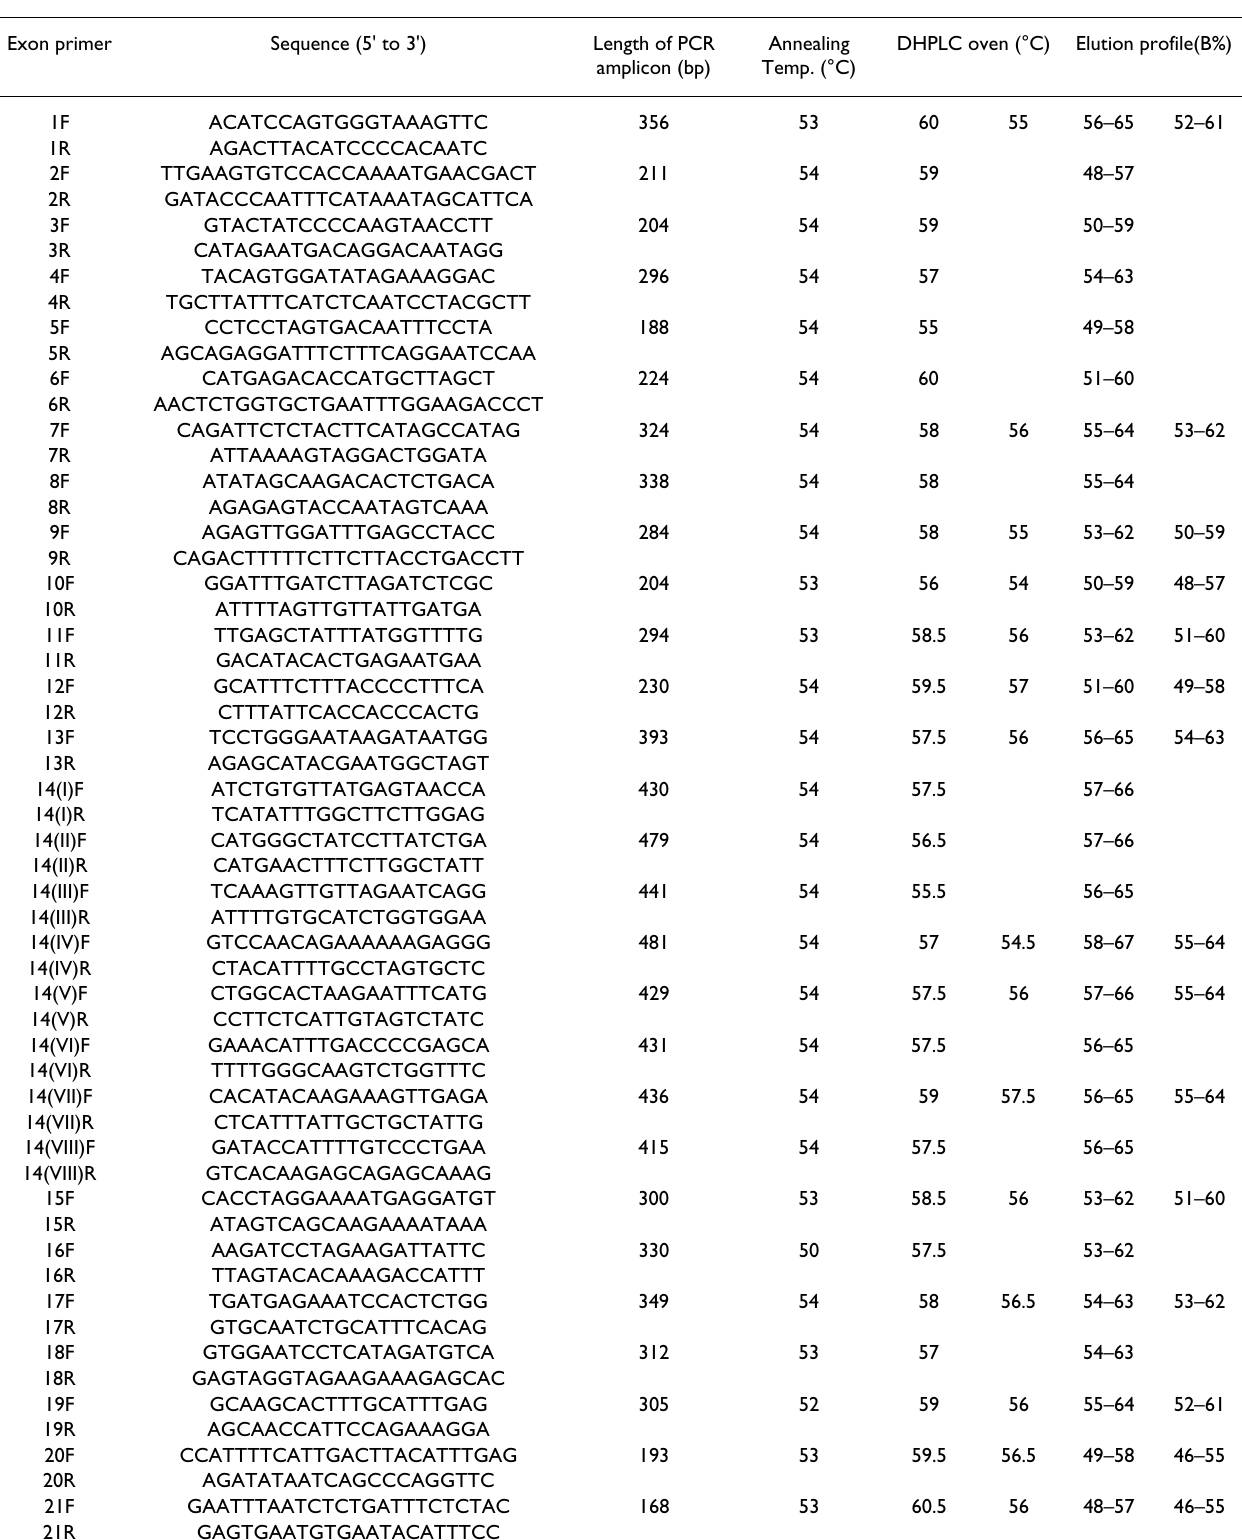
Table 1: Primer pairs and PCR conditions for DHPLC analysis. HA Primer pairs and PCR conditions for DHPLC